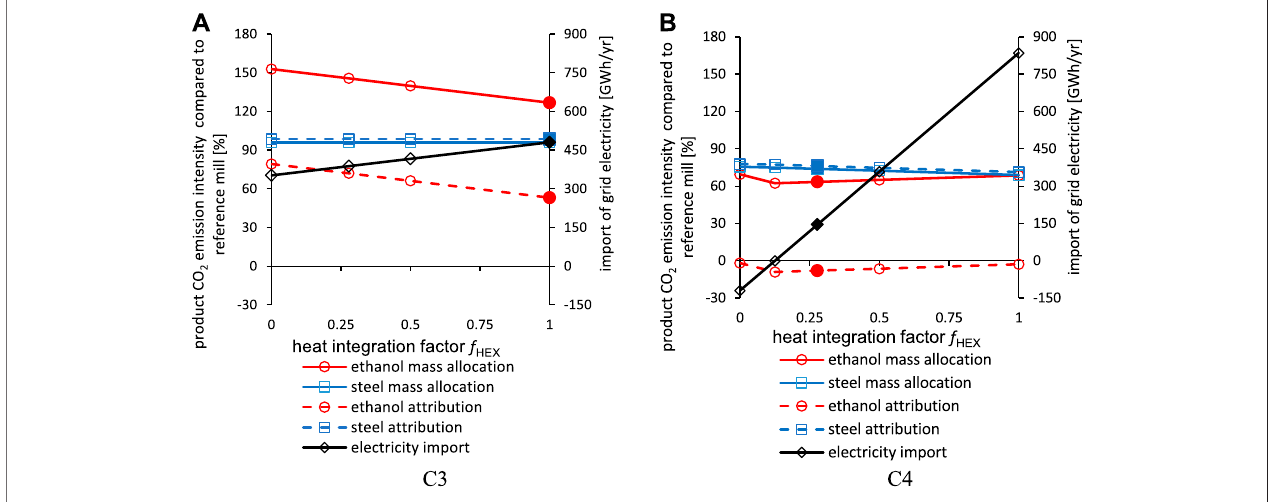
FIGURE 13 | CO 2 emission intensities of steel and ethanol depending on the extent of heat integration for a steel mill in Bio-PCI to ethanol con fi guration without CCS (A) andwithCCS (B) .The fi lledsymbolsrepresentthedefaultassumptionsforheatintegrationwiththereferencesteelmillCHPandagridintensityof295.6 gCO2/ kWh (EU